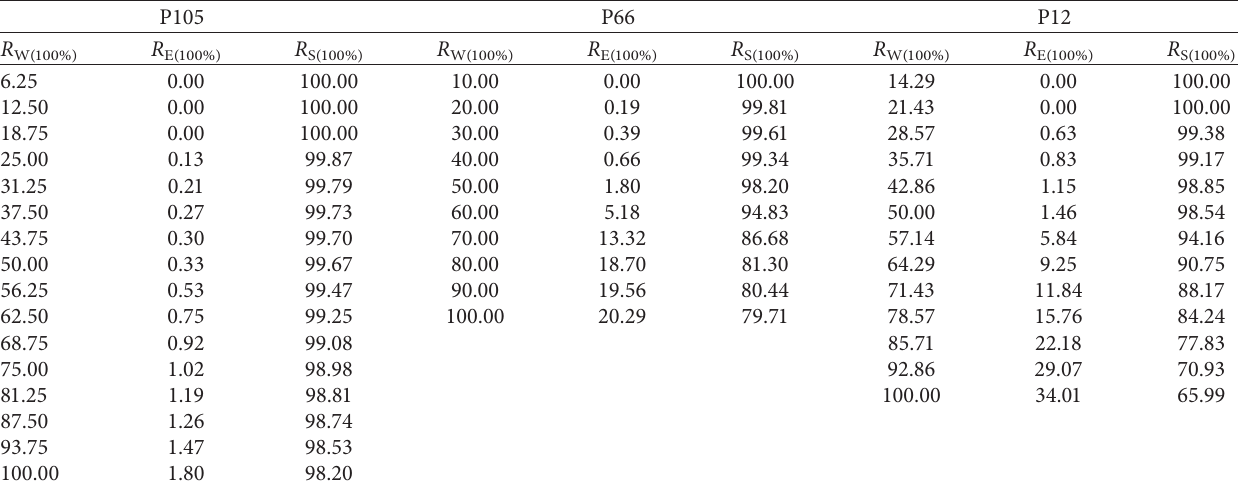
Figure 14: Load transfer mechanism of P105. Table 2: Proportion of shaft and toe resistance under working